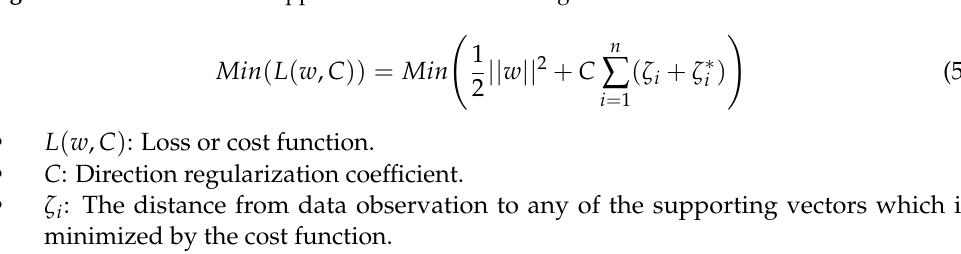
Figure 6. One-dimensional support vector machine for